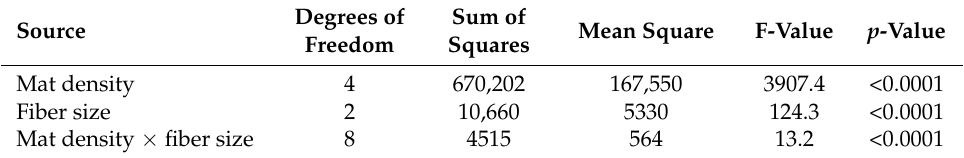
Table 2. Analysis of variance performed for the mat porosity at different density levels and fiber sizes. Figure 10. Interaction of mat porosity versus density at different fiber sizes.